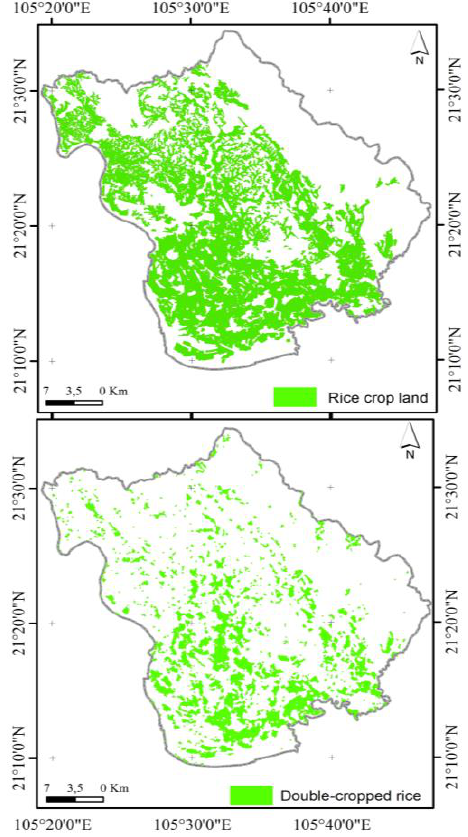
Figure 9. Rice map derived from the WSM dataset (below) and